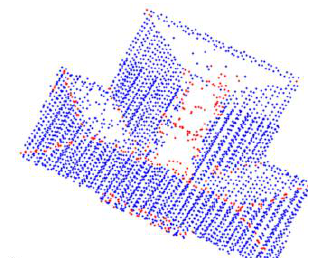
Figure 2. Eigenvalue Analysis. Planar Points (red) Non-Planar Points (blue)